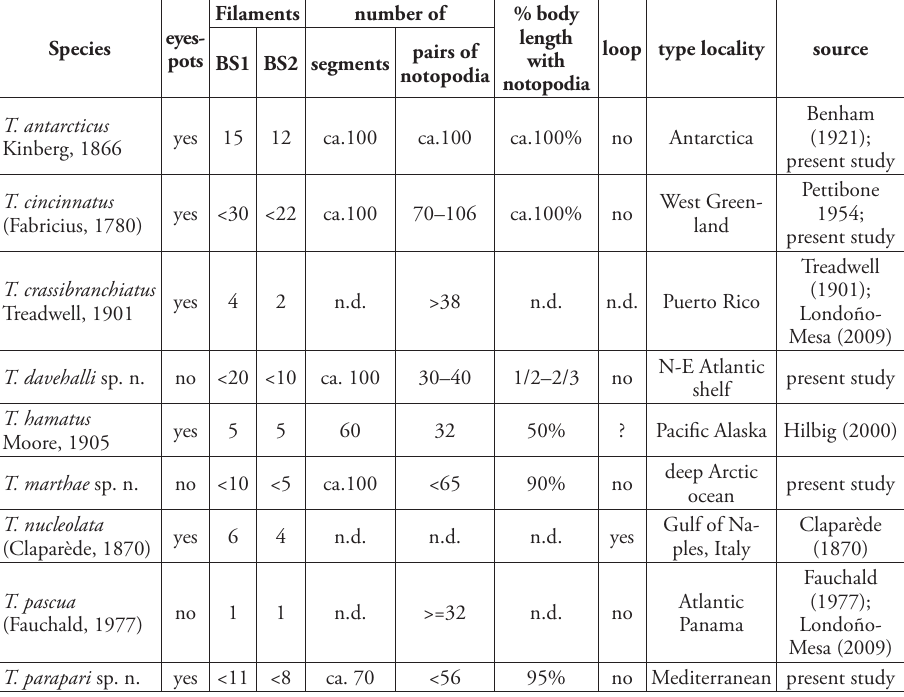
Table 2. Synoptic character data for all known species of the genus Thelepus with two branchiferous seg- ments. Abbreviations: n.d. – absence of